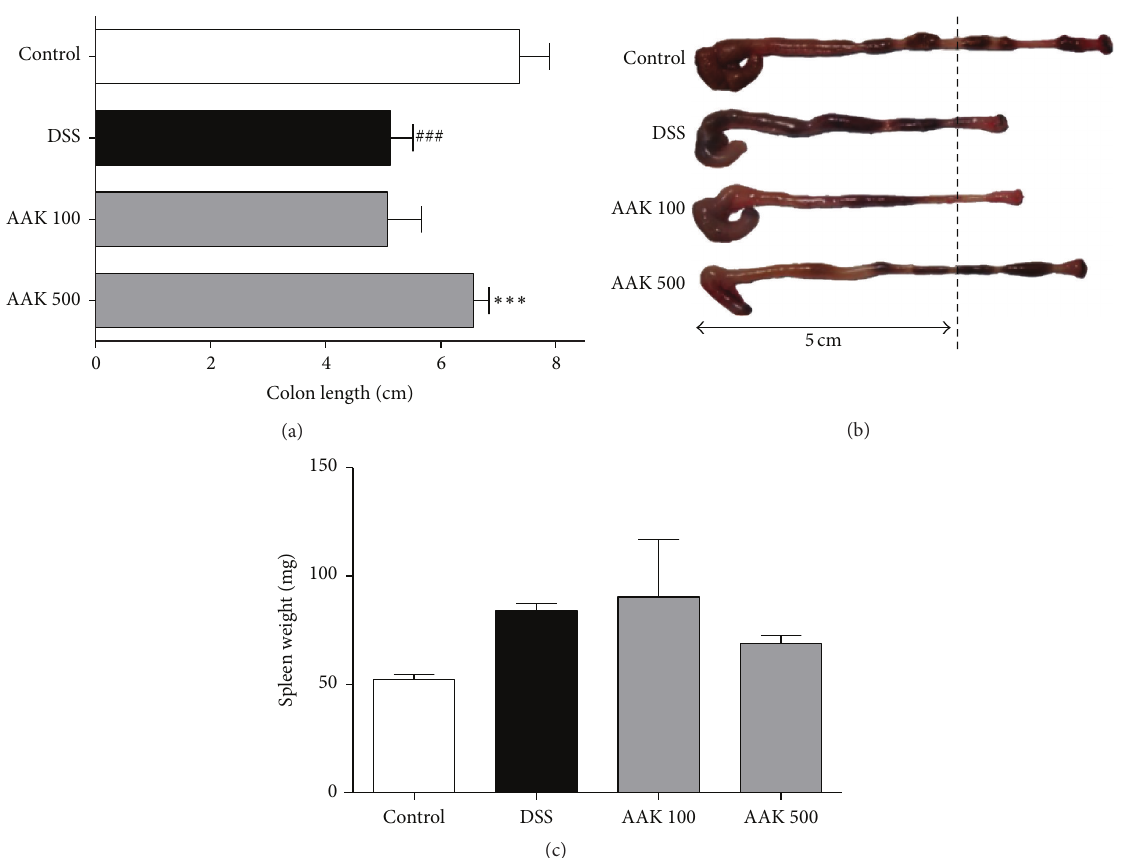
Figure 3: Effects of AAK extract on the colon length and spleen weight of DSS-induced colitis. Mice colon and spleen samples were collected on the day of sacrifice. (a) Colon length of each group. (b) Macroscopic images of the colon. (c) Spleen weight of each group. Data represent the mean ± SD ( 𝑛 = 4 – 6 per group). ### 𝑝 < 0.001 versus control; ∗∗∗ 𝑝 < 0.001 versus